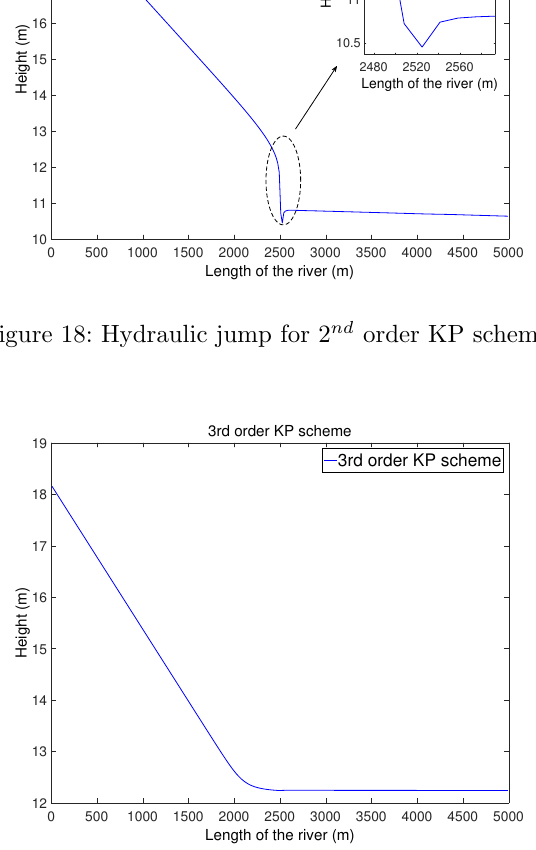
Figure 19: Hydraulic jump for 3 rd order KP